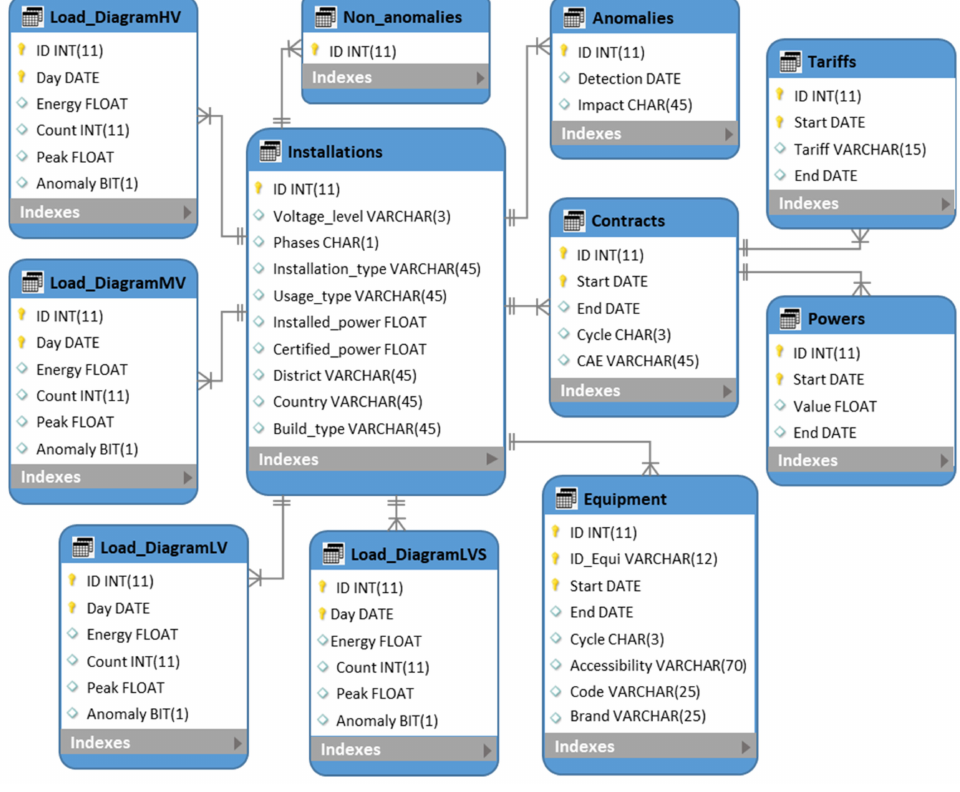
Figure 1. Structure of the